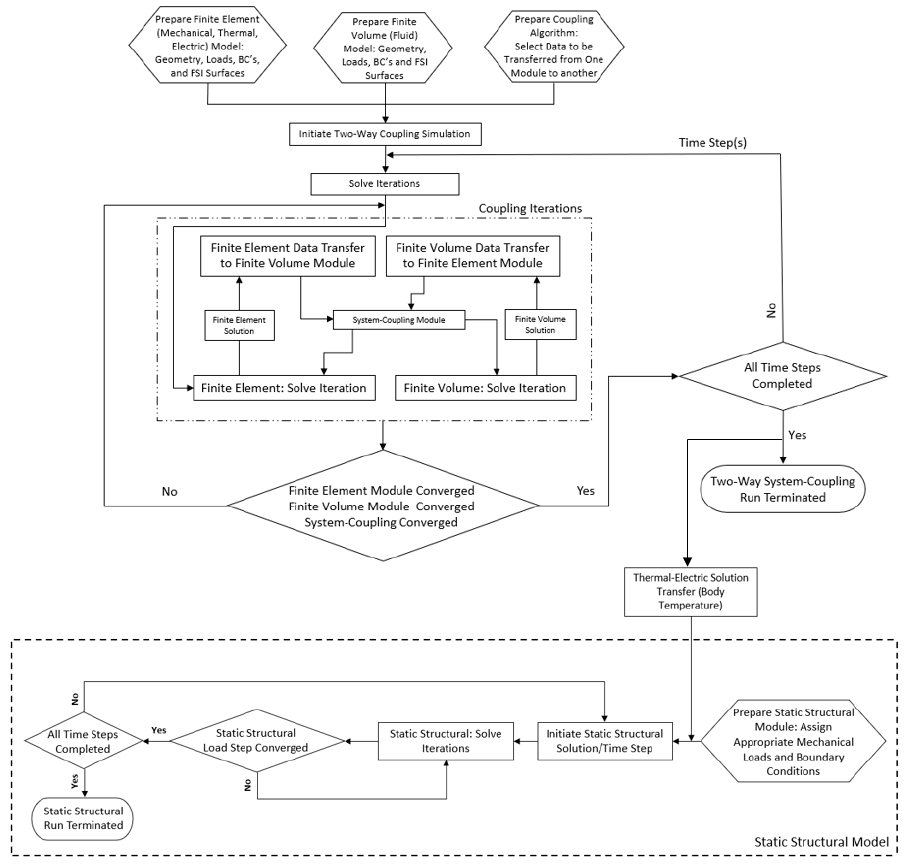
Figure 6. Two-way system coupling—process flow execution. The process flow is initiated by the definition of both finite elements (thermal-electric); finite volume geometries, loads, and boundary conditions; and the interfacing surfaces between the pair. At this stage, the data transfer sets between the finite element and finite volume modules are selected (in this study, data transfer sets during the fully coupled analysis were purely thermal). The solution is then initiated whereby the finite element and finite volume solvers calculate iterations simultaneously, with data transfer between the two models being managed by the coupling algorithm. Once all iterations and load steps have converged, the coupled analysis is terminated. Another finite element model (denoted by the ‘static structural model’) is prepared, including any additionally required structural loads and boundary conditions. The body temperature results as obtained by the coupled analysis are then sequentially transferred as a thermal load to this structural finite element model for the calculation of thermal stresses and strains. All coupled analyses are implemented in Ansys ® Academic Research Mechanical, Release 21.1 and Ansys ® Academic Research Fluent, Release 21.1.